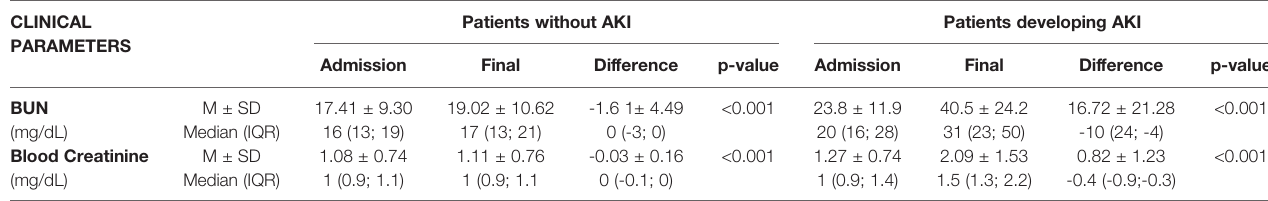
TABLE 3 | Variation of blood urea nitrogen (BUN) and blood creatinine from hospital admission to end of follow-up (hospital discharge or death). CLINICAL PARAMETERS